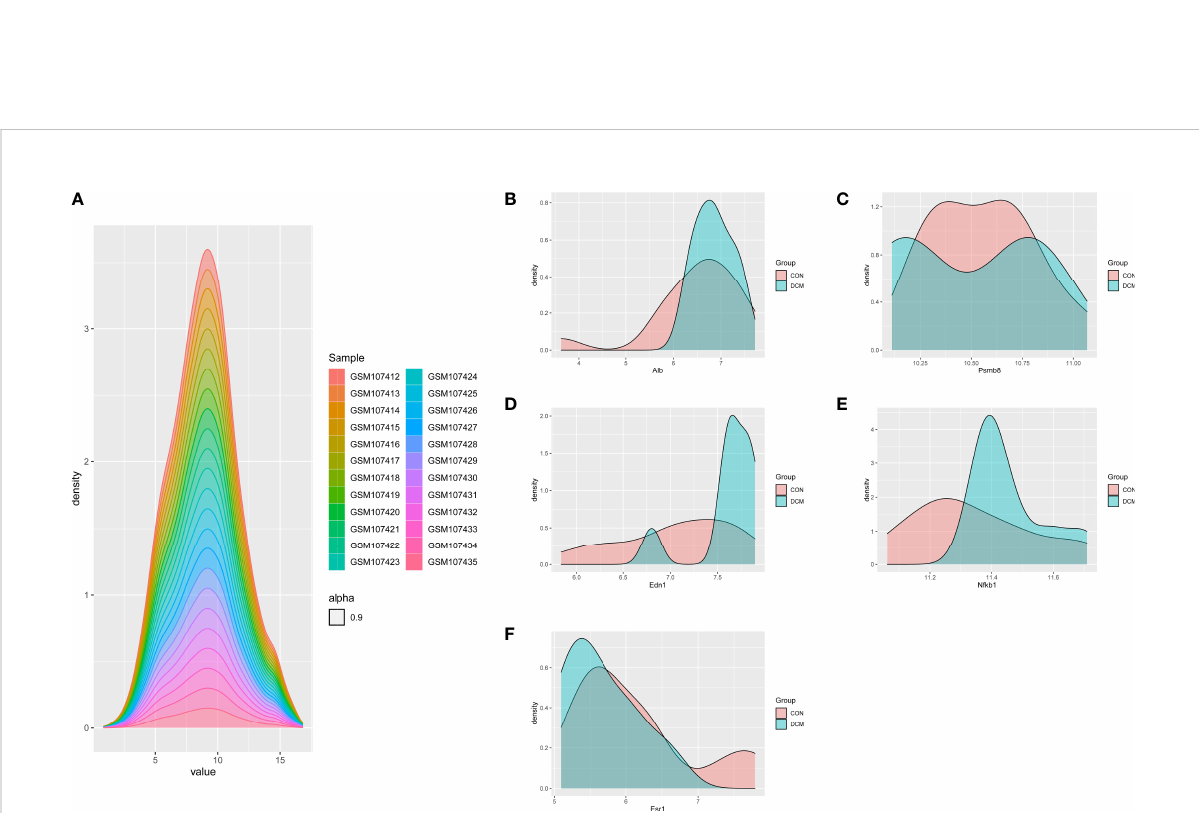
FIGURE 4 Density plots of the dataset GSE4745, showing a smooth distribution of the points along the numeric axis. The peaks of the density plot are at the locations with the highest concentration of points. (A) density plot of sample dataset. (B – F) Density plots of hub